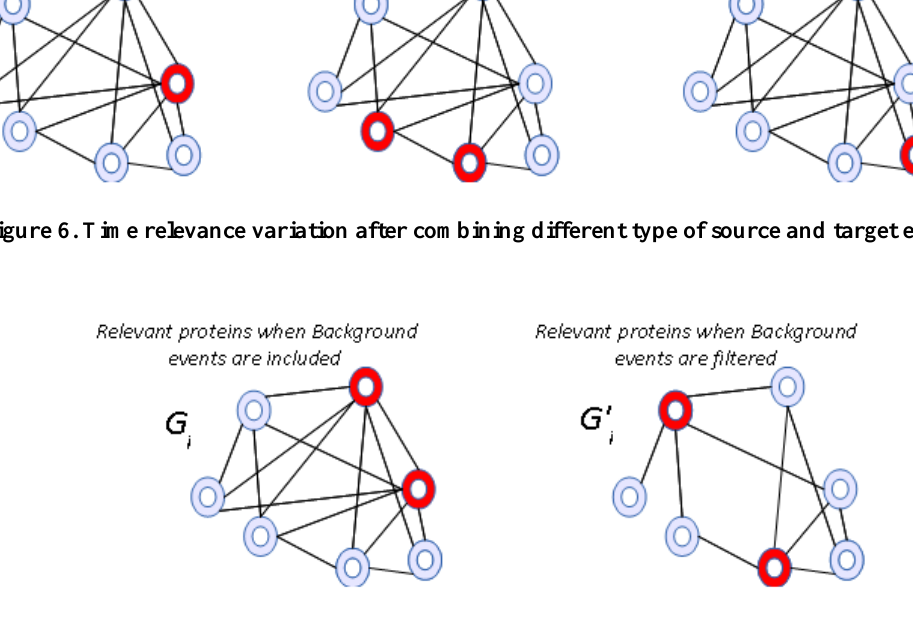
Figure 7. Time relevance with and without background